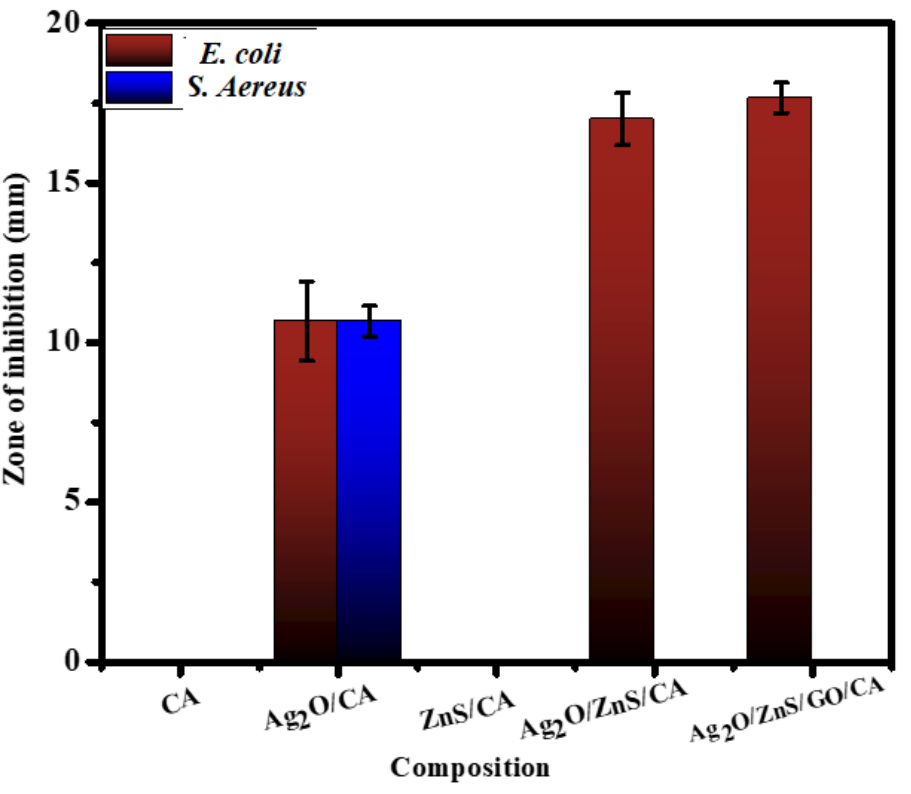
Figure 8. Antibacterial activity of the different composites after 24 h of exposure against E. coli and S. aureus .